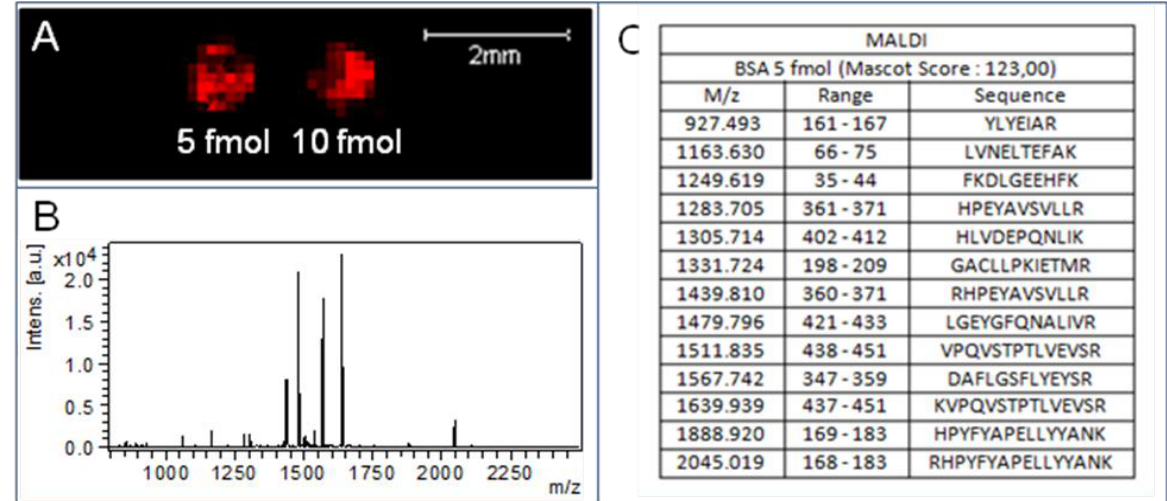
Figure 3. on chip MALDI-MS imaging and analysis of a BSA digest after matrix deposition by Imageprep. ( A ) The distribution of a specific tryptic BSA peptide ( m/z 1487.79) is shown in red. ( B ) MS spectrum obtained on one laser position in the 5 fmol BSA digest spot identifying Bovin Serum Albumin with a Mascot Score of 123.00 and 13 specific peptides ( C